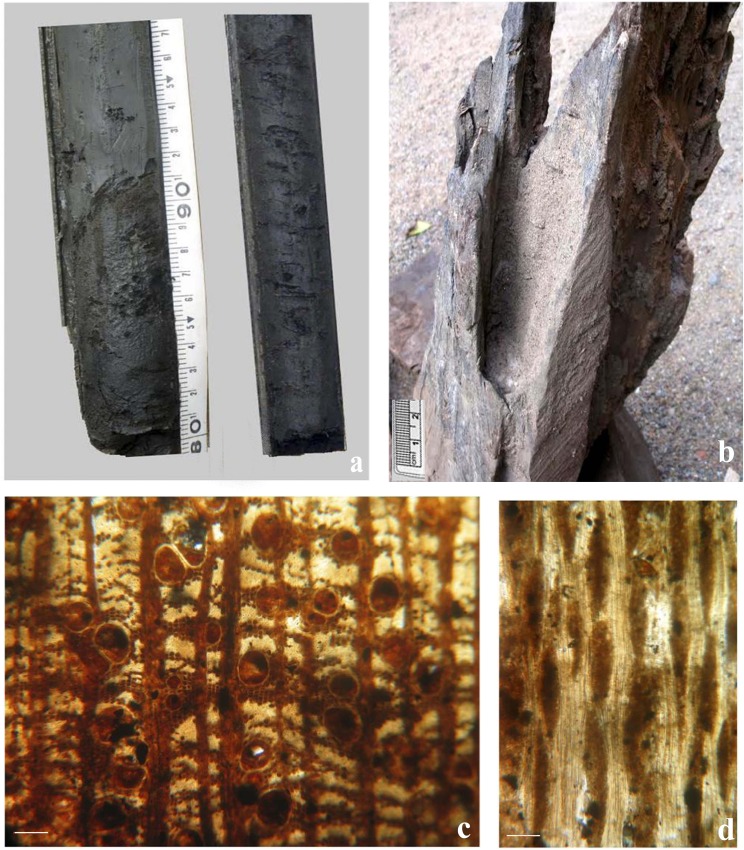
Subsurface sample and wood details from peatland in Pamba basin, Kerala.a. Split core having wood remains entombed in grey clay matrix obtained from a depth of 9.2 m below ground level at Puvathur. b. A piece of subfossil log retrieved from a well at Puvathur (MACS G 5419) c. Transverse section of Cynometra sp. Puvathur (PVTR) Scale bar = 250μm (MACS G/ MF 2734). d. Tangential longitudinal section of Cynometra sp. Puvathur (PVTR) Scale bar = 250μm (MACS G/ MF 2735).